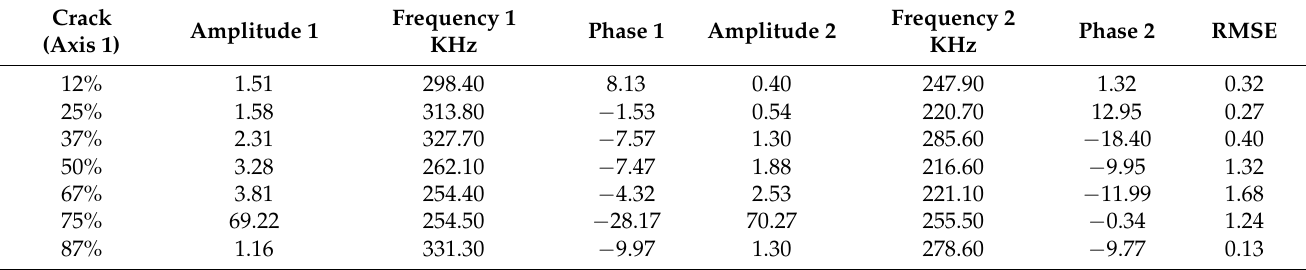
Table 3. Optimized parameters and error terms for the numerical model for the cracks along axis